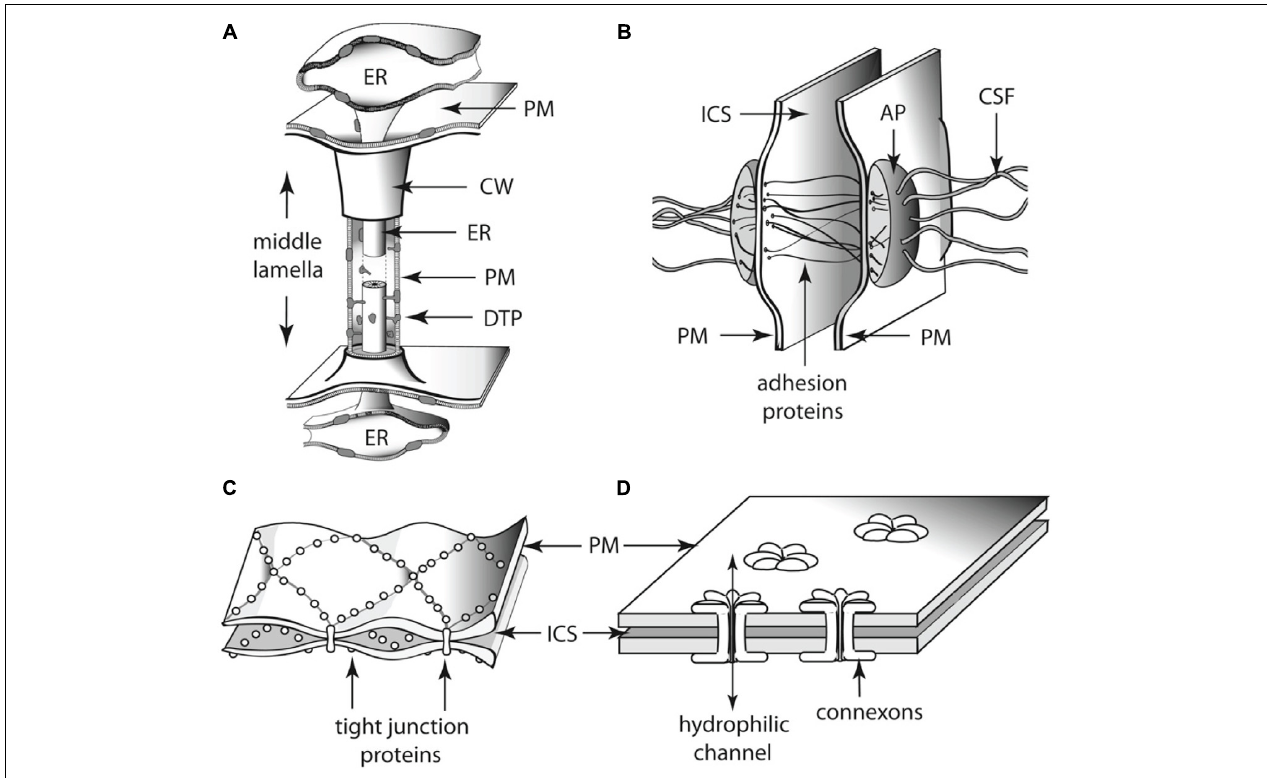
FIGURE 6 | Schematics of the diversity of intercellular communication among adjoining (A) land plant and (B–D) animal cells. Each of these cell-to-cell linkages participates in the establishment of cell polarity as well as physiological communication among adjoining cells. Thus, each represents an analogous evolutionary innovation for two of the essential features of multicellularity. (A) Plasmodesma. (B) Desmosome. (C) Tight junctions. (D) Gap junctions. AP, attachment plaque (plakoglobins); CSF, cytoskeletal filaments (keratin); CW, cell wall; DTP, desmotubular proteins; ER, endoplasmic reticulum; ICS, intercellular space; PM, plasma